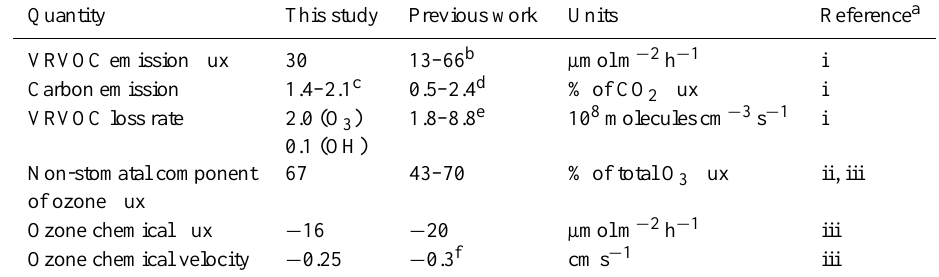
Table 3. Comparison of model results from the high reactivity (HR) scenario with previous observationally-constrained